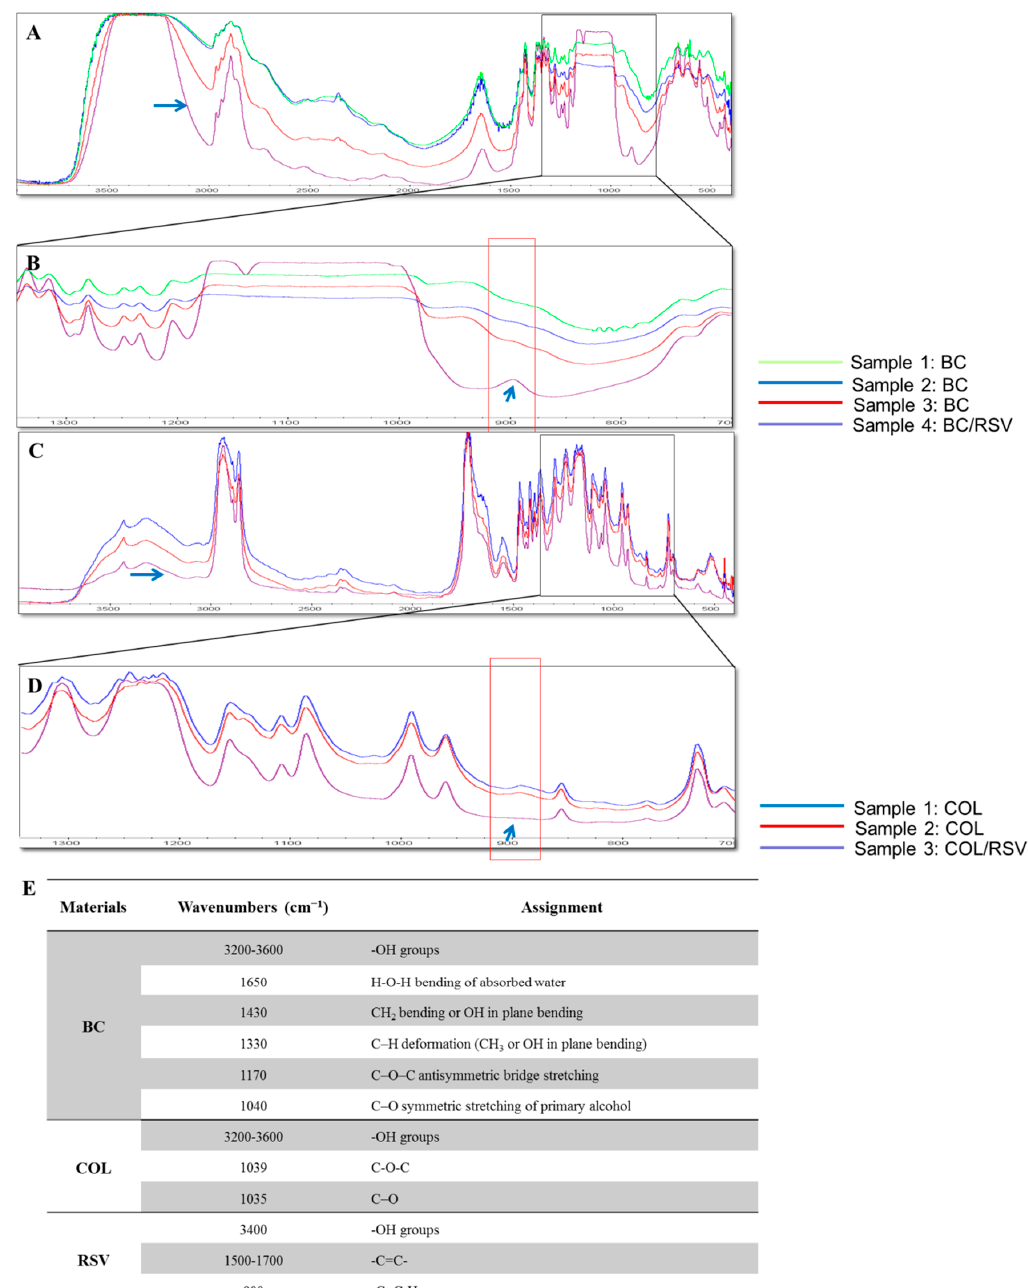
Figure 1. FT-IR spectrum of the resveratrol (RSV) particle. ( A ) Bacterial cellulose (BC)/RSV scaffold (purple line), ( B ) enlargement of ( A ), ( C ) type I collagen (COL)/RSV scaffold, and ( D ) enlargement of ( C ). Black squares are enlarged areas, and red squares indicate the region of the RSV spectrum. ( E ) FT-IR identification of the RSV regions in the scaffolds.